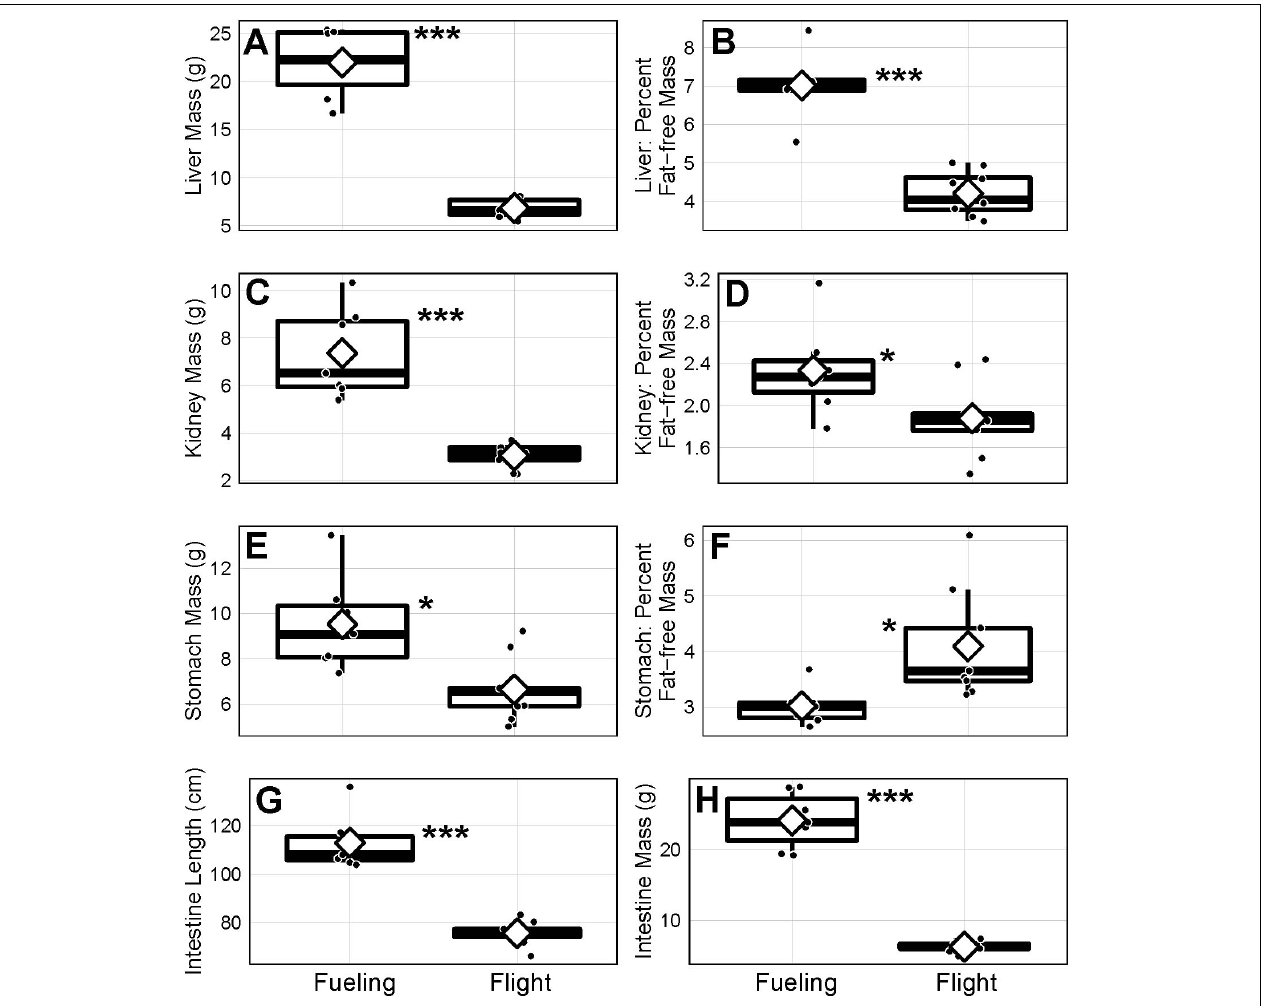
FIGURE 3 | Mass (A,C,E,H) , mass relative to fat-free mass (B,D,F) , and length (G) of body components of juvenile bar-tailed godwits sampled in Alaska, United States, during the fueling ( n = 2 females and 5 males) and flight ( n = 9 males) annual-cycle stages of their first southward trans-Pacific migration. Horizontal lines represent the median, diamonds the mean, black circles the actual values, boxes the 25th and 75th percentiles, and whiskers the range of values. Statistically significant group differences based on analysis of variance analyses controlling for effects of sex represented by * p ≤ 0.05, ** p ≤ 0.01, and *** p ≤ 0.001.